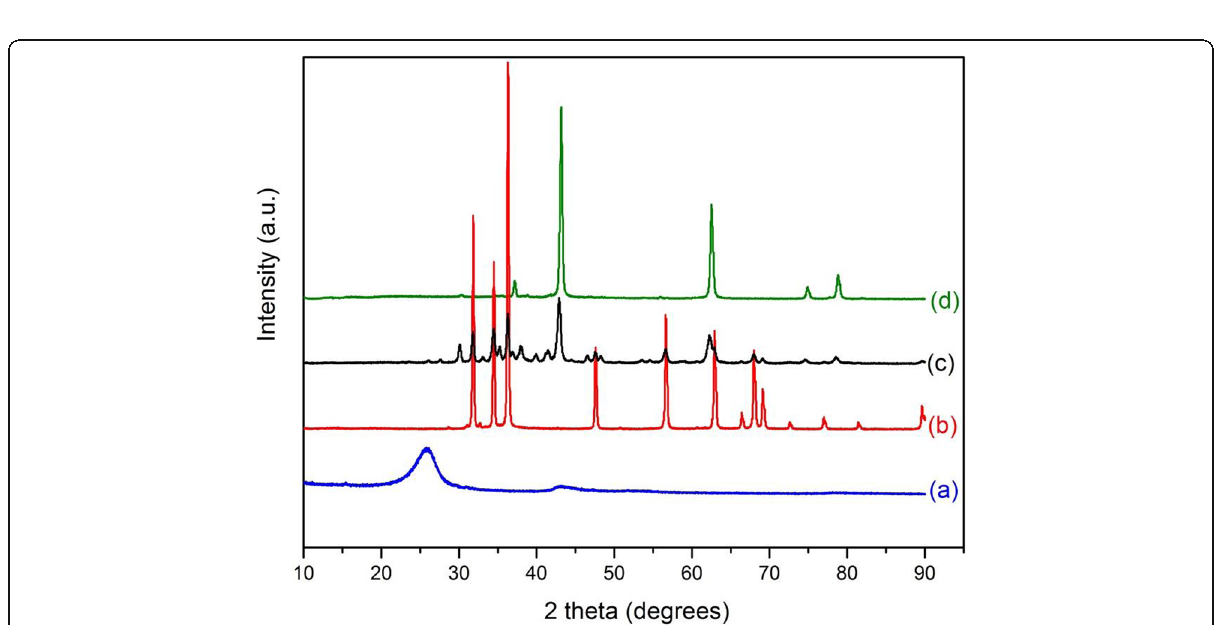
Fig. 3 XRD pattern of a CNFs, b ZnO, c MgO-ZnO@CNFs, and d